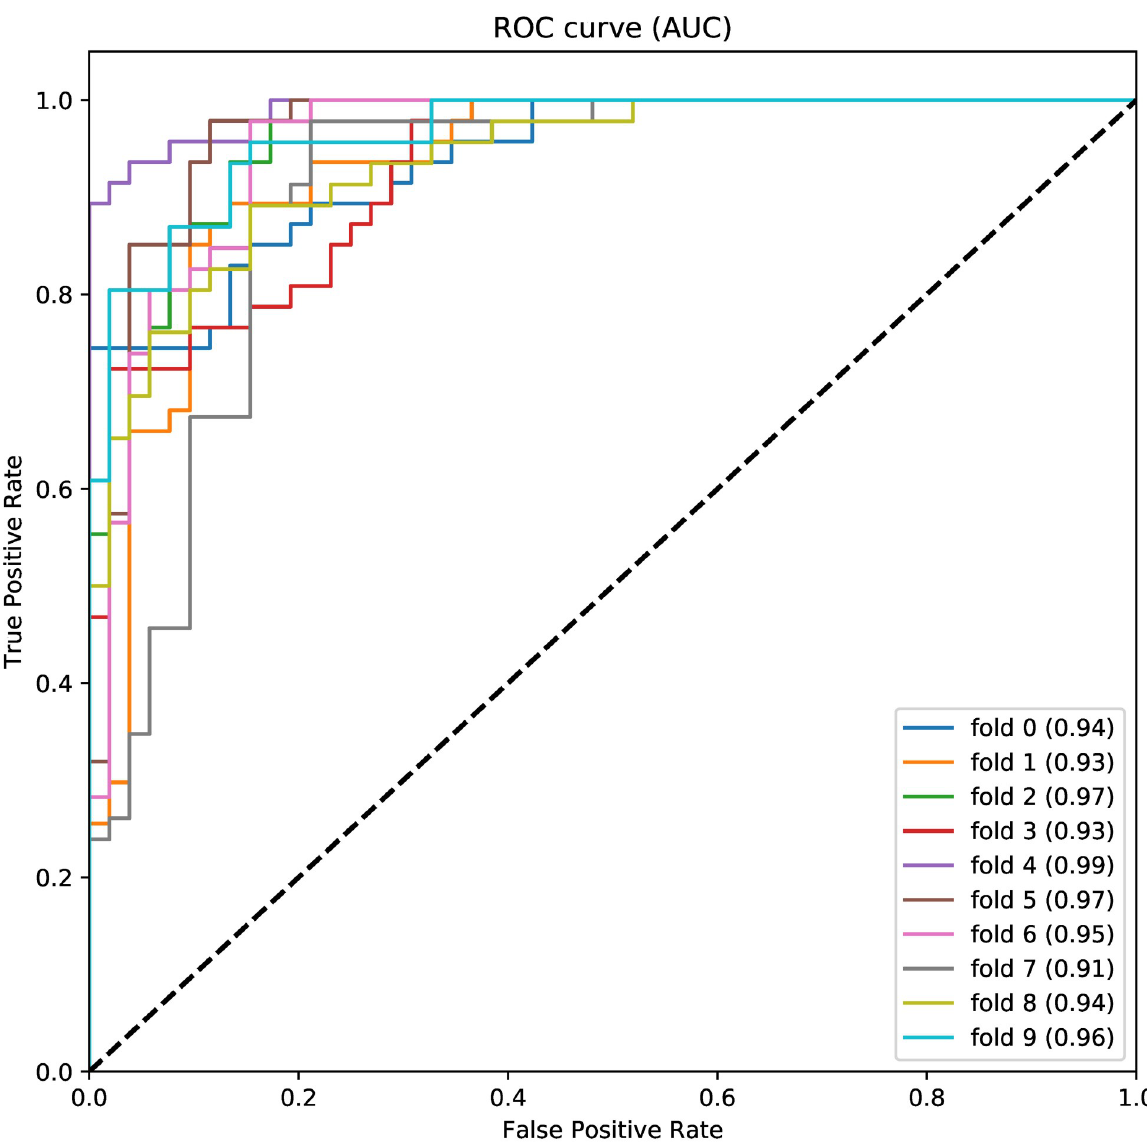
Fig 3. ROC curves for one 10-fold cross-validation using 26 selected features.